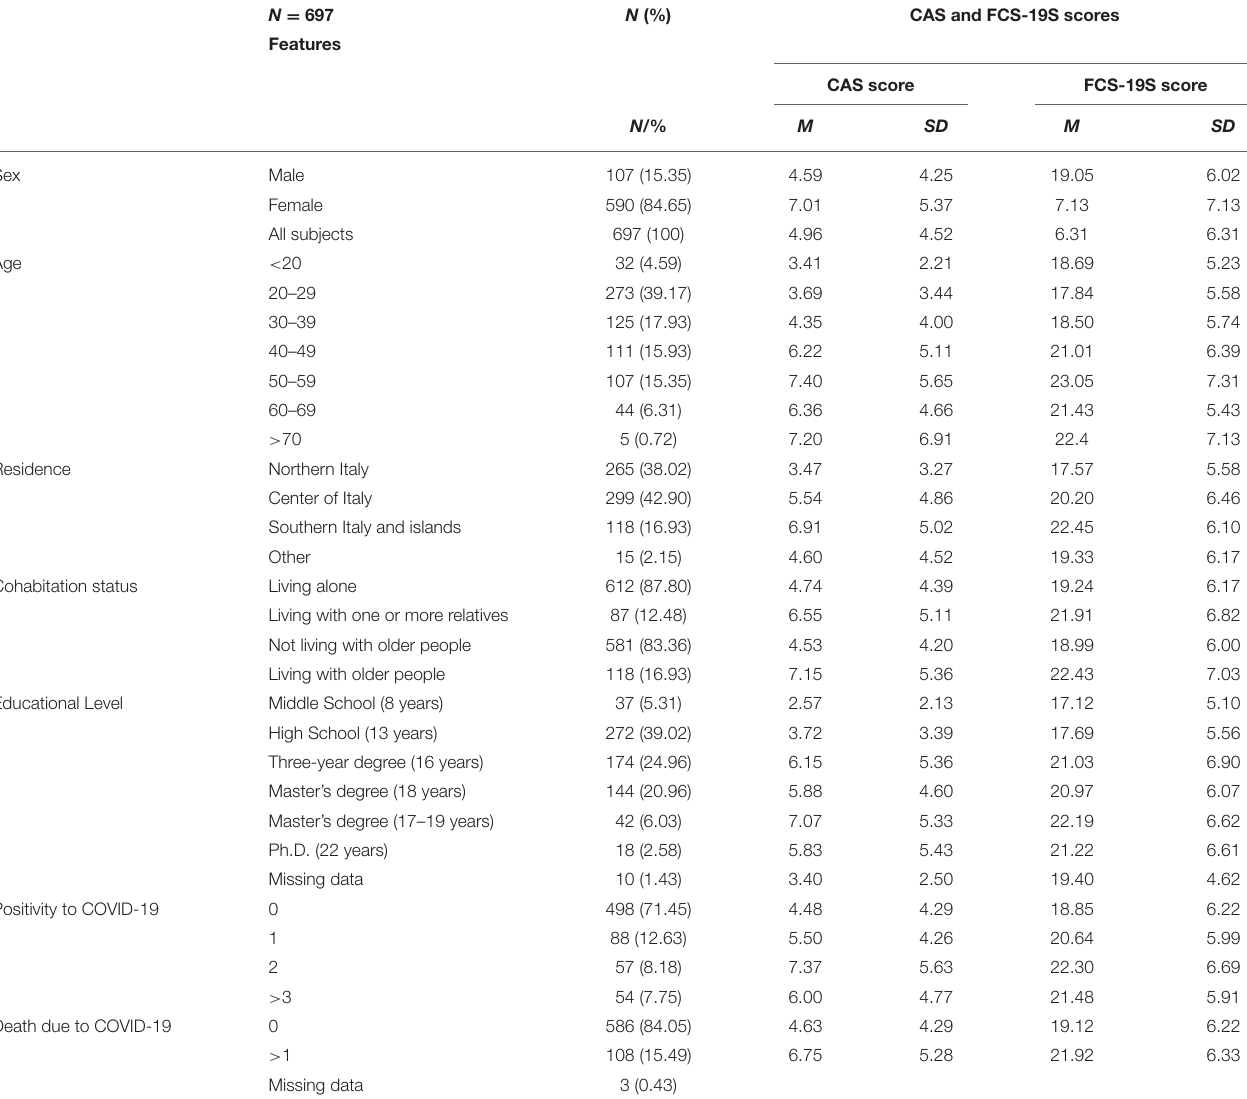
TABLE 1 | Sample characteristics describe the number of subjects ( N ), percentage (%), mean ( M ), and standard deviation ( SD